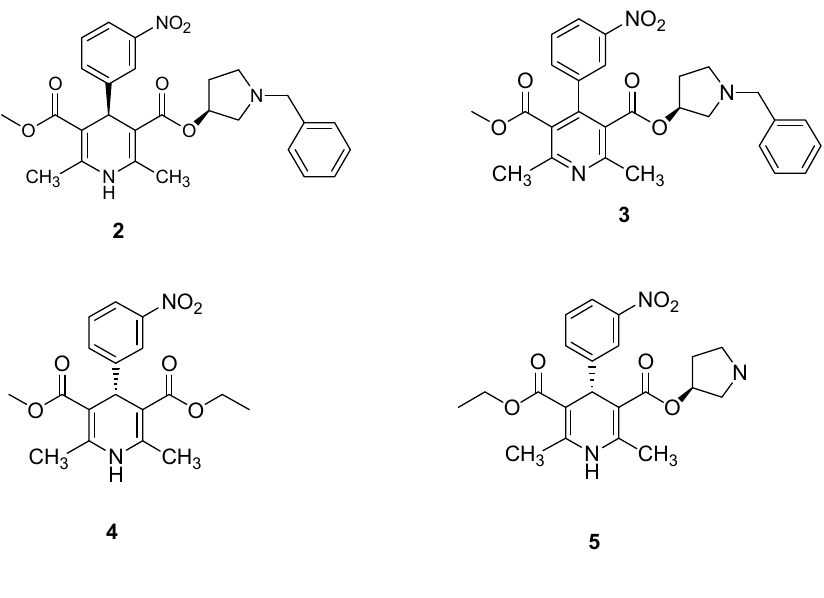
Figure 2. Structures of the